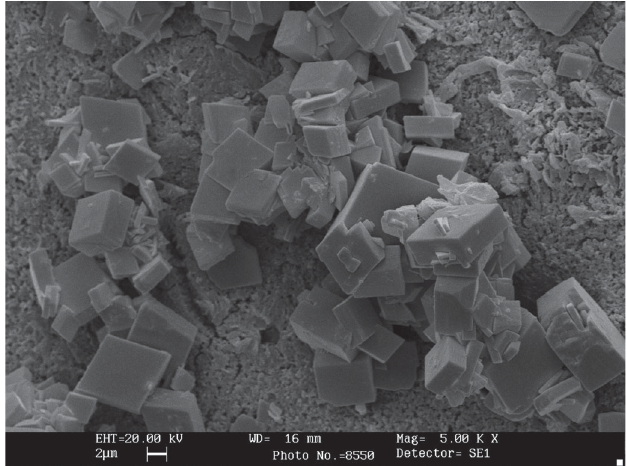
Fig. 6 - SEM image of the ScaTe demonstrating presence of residual tetracycline on dentin surface, and all dentin tubules